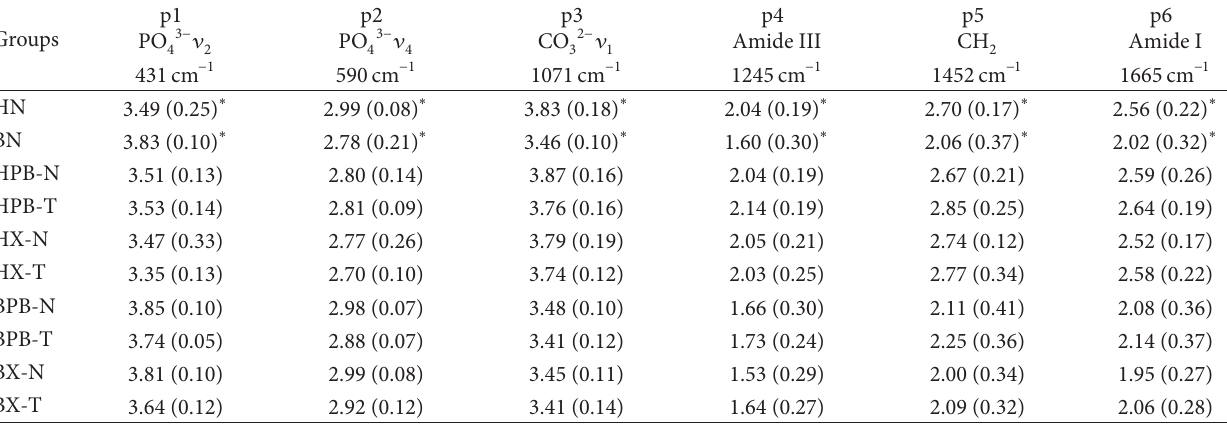
T 2: Mean values (standard deviation) of integrated areas obtained from Raman spectra: inorganic peaks (p1–p3) and organic peaks (p4–p6) of normal (N) and treated (T) dentin of experimental groups (